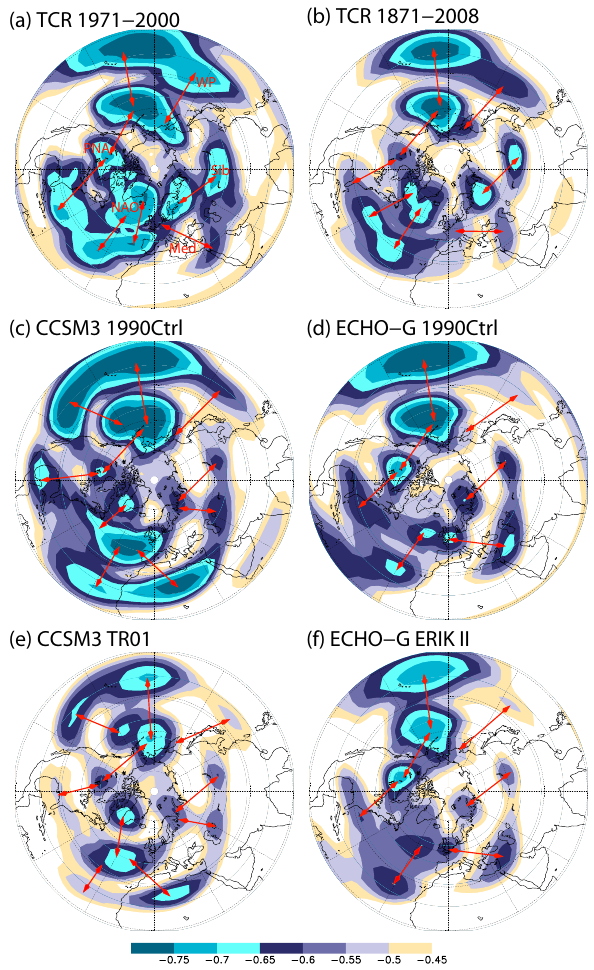
Fig. 2. Teleconnectivity based on the 500hPa geopotential height: (a) TCR for the reference period 1971–2000, (b) TCR for the pe- riod 1871–2008, (c) Ctrl1990 of CCSM3, (d) Ctrl1990 of ECHO-G, (e) TR1a, and (f) Erik II. Note that other simulations TR2a–TR4a and TR1b show a similar pattern as (e) and Erik I resembles the pattern of (f) , therefore they are not shown. The arrows illustrate teleconnection axes and are estimated by one-point correlations in each of the centres of action, as suggested by Wallace and Gutzler (1981) and Raible et al. (2006). They show NAO-type, PNA-type, and WP-type patterns as well as a pattern over Siberia (Sib) and a pattern connecting the eastern Mediterranean with central Europe (Med) as denoted in (a)